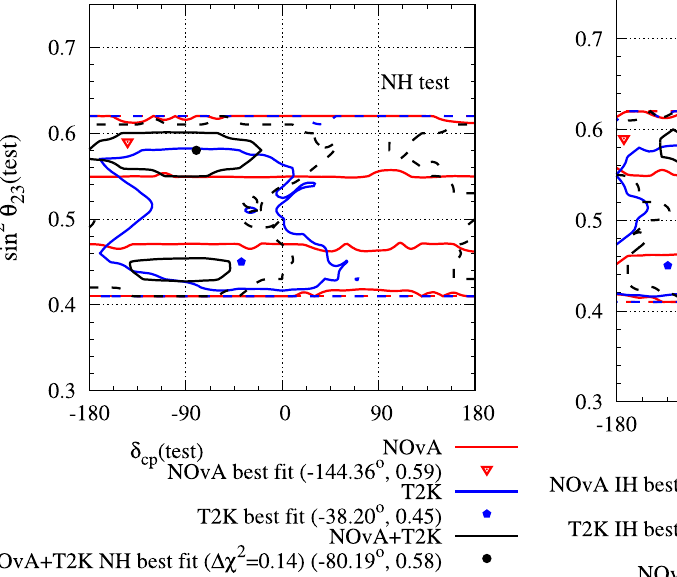
Fig. 10 Allowed region in the sin 2 θ 23 − δ CP plane after analysing NO ν A and T2K complete data set with LIV hypothesis. The left (right) panel represents test hierarchy NH (IH). The red (blue) lines indicate the results for NO ν A (T2K) and the black line indicates the combined